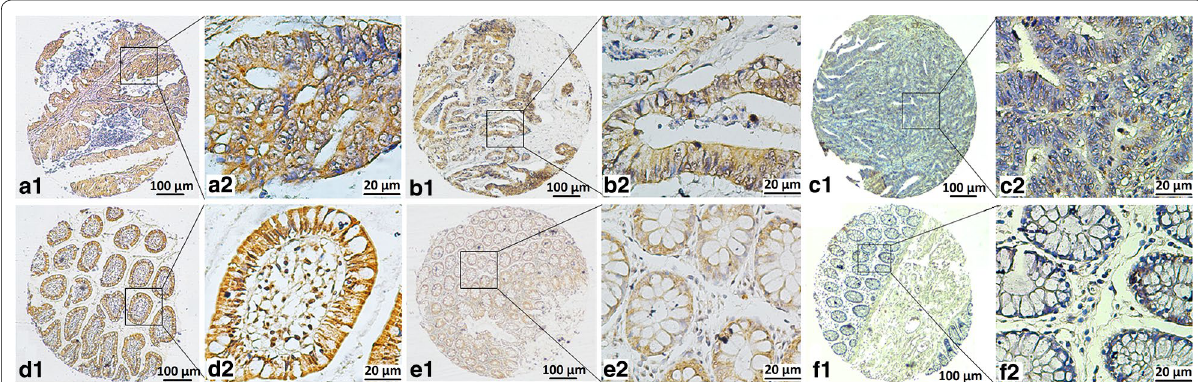
Fig. 1 Representative immunohistochemical (IHC) staining of voltage-gated sodium channel 1.5 (Nav1.5) protein in tissue microarray (TMA). a1 , a2 colon adenocarcinoma with high Nav1.5 expression, with strong intensity and 100% malignant cells staining in the plasma membrane; b1 , b2 colon adenocarcinoma with moderate Nav1.5 expression, with moderate intensity and 75% malignant cells staining in the cell membrane; c1 , c2 colon adenocarcinoma with low Nav1.5 expression, with week intensity and 45% malignant cells staining in the cell membrane; d1 , d2 high Nav1.5 expression in tumor-adjacent normal tissue, with strong intensity and 100% epithelial cells staining in the plasma membrane; e1 , e2 moderate Nav1.5 expression in tumor-adjacent normal tissue, with moderate intensity and 80% epithelial cells staining in the cell membrane; f1 , f2 negative Nav1.5 expression in tumor-adjacent normal tissue